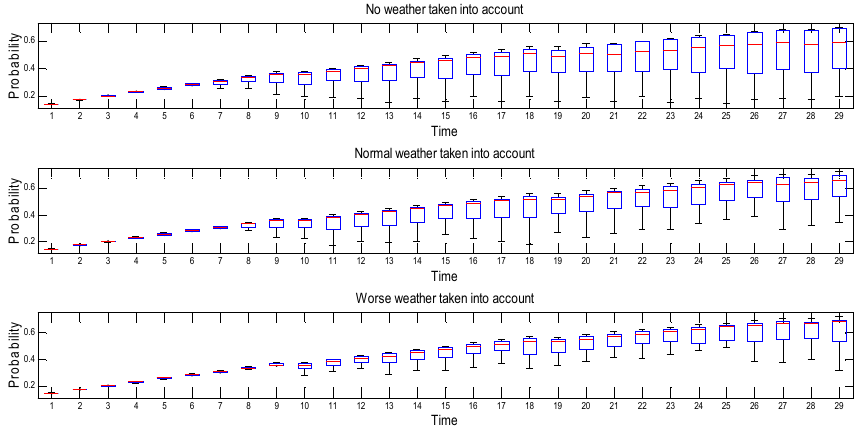
Figure 12. Influence of exogenous variables on the state of the offshore wind farm.